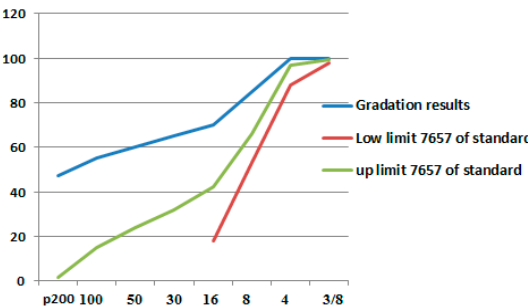
Figure 2. Diagram of the grading of Pumice of the Tabriz, Bostanabad mine. Table 3. Grading test specifications of Pumice of the Tabriz, Bostanabad mine.